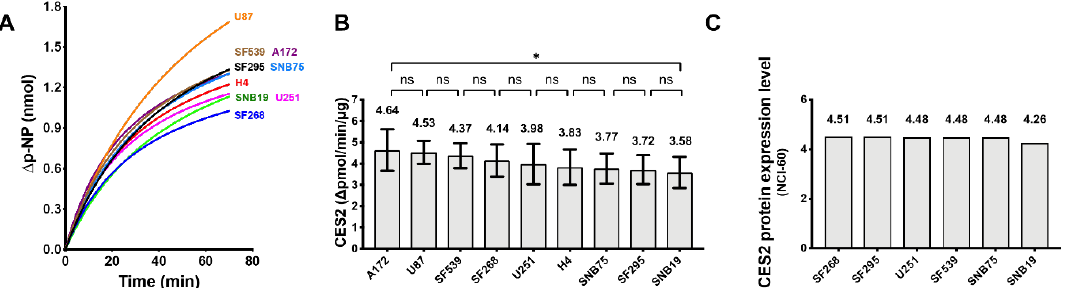
Figure 7. Comparison of carboxylesterase 2 (CES2) activity in the WCE of GBM cell lines. ( A ) The time course of p-NP (p-nitrophenol) generation attributable to CES2, calculated by subtracting the p-NP signal obtained in the presence of the CES2 inhibitor loperamide; ( B ) the variation in CES2 activity in GBM cell lines measured over the initial 20 min of reaction. Results represent the average from nine replicate measurements in two experiments; ( C ) The CES2 protein expression level based on SWATH-MS (Sequential Windowed Acquisition of All Theoretical Fragment Ion Mass Spectra) from the CellMinerCDB database for the GBM cell lines in the NCI-60 panel.